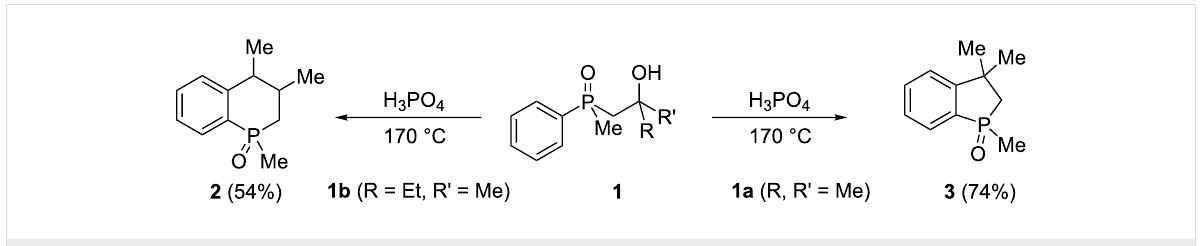
Scheme 2: Cyclization of 1a and 1b under acidic